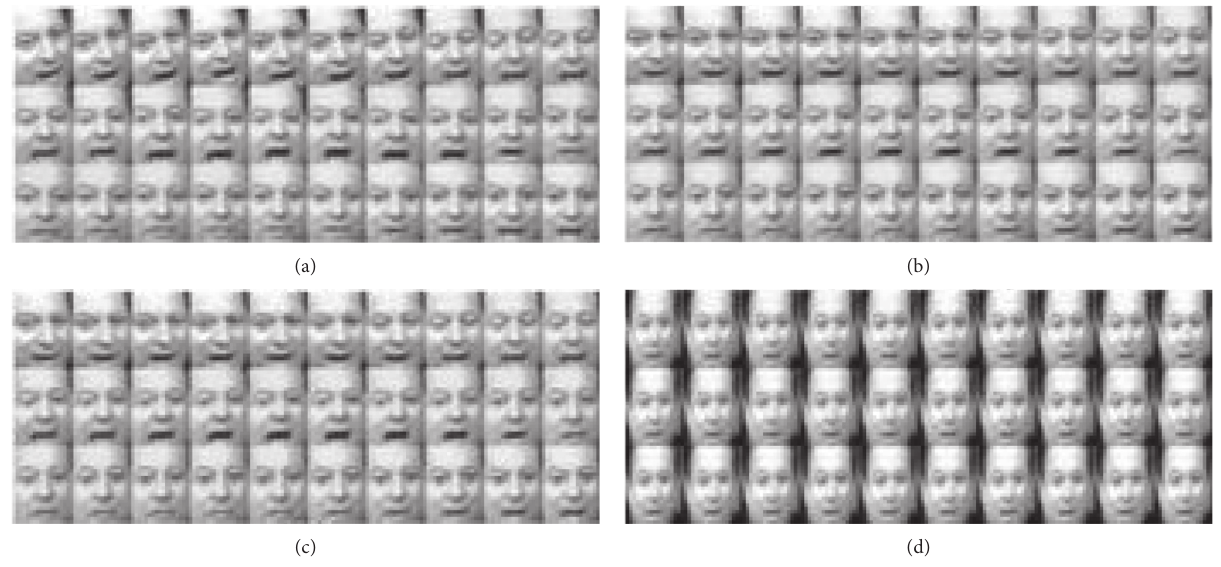
Figure 3: Some recovered video sequence face images. (a) Original, (b) NQLSD, (c) RASL, and (d) proposed method.